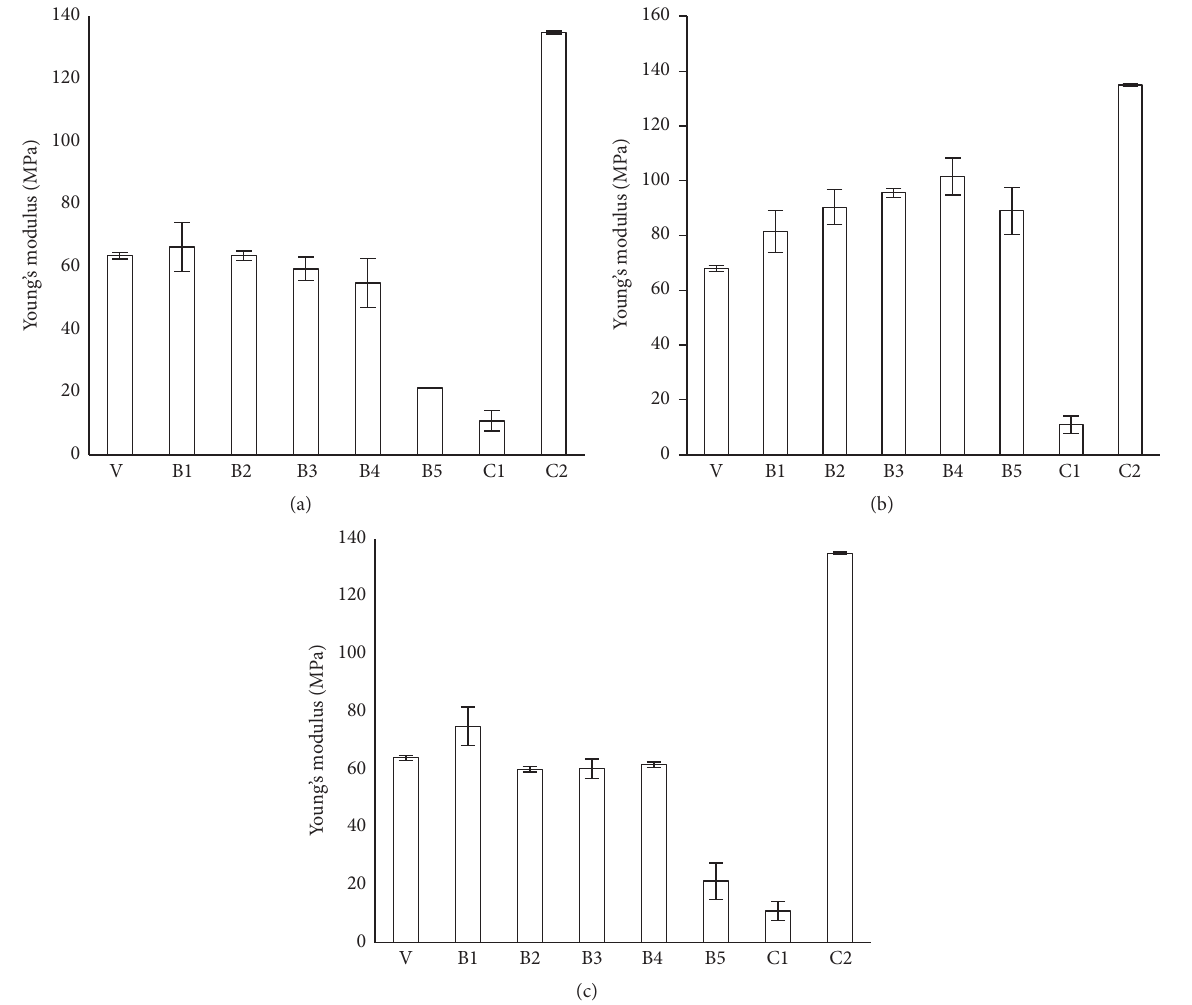
Figure1:Young’smodulus(MPa)measuredforthestudiedmaterialsincomparisontothecommercialgradeproducts.DieHeadTemperature (DHT) = (a) 175 ∘ C, (b) 185 ∘ C and (c) 195 ∘